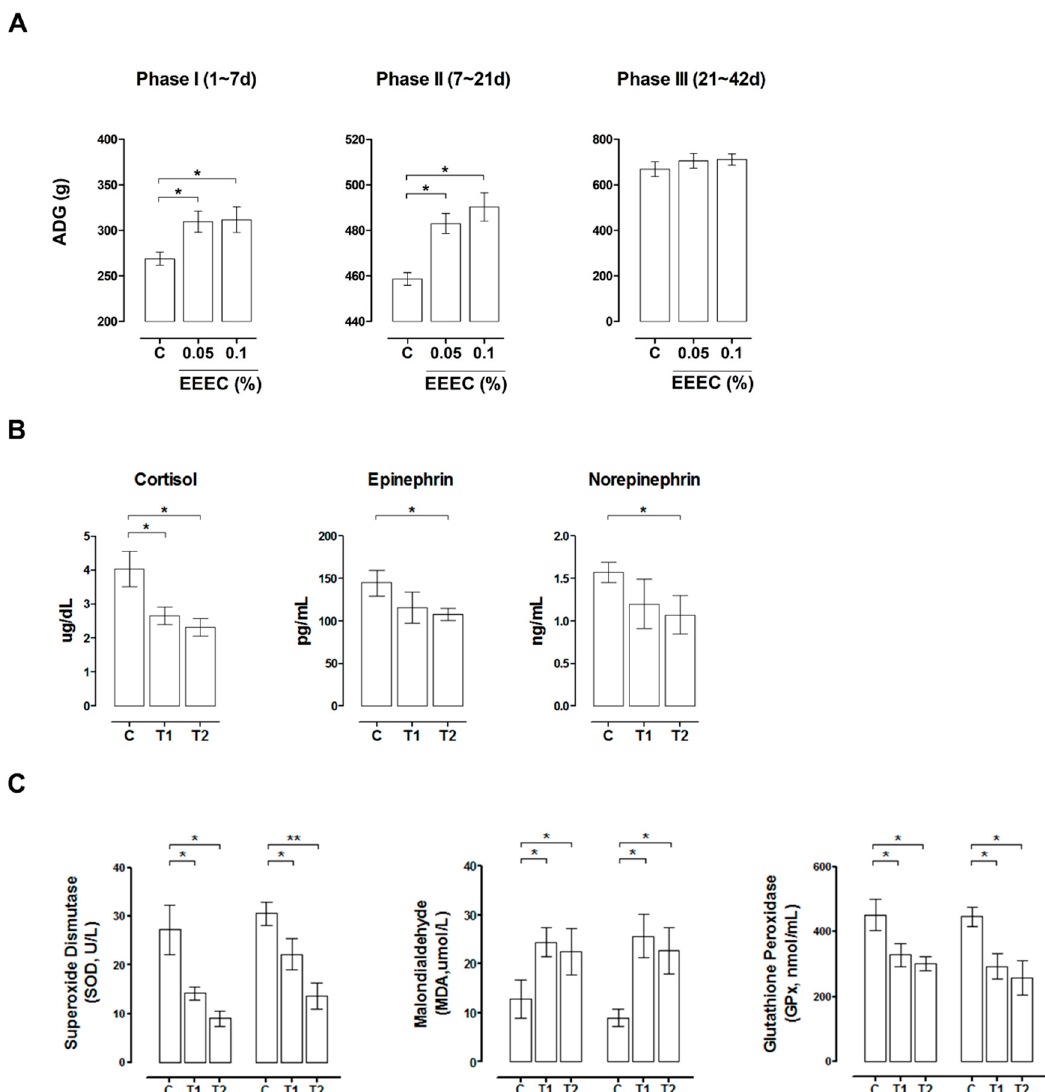
Figure 8. In vivo feeding trial during the suckling-to-weaning transition in pigs. The pigs were sorted into pens (n = 5 per pen, eight pens per treatment) and assigned to the following feeding groups: corn-soybean meal (C, control); control + 0.05% EEEC (T1); control + 0.1% EEEC (T2). ( A ) Dietary ethanol extract of dried E. cava (EEEC) supplementation improved average daily gain (ADG) in pigs during three developmental phases (days 1–7, 7–21, and 21–42). Serum levels of stress-related hormones, such as cortisol, epinephrine, and norepinephrine ( B ); and oxidative stress markers, such as superoxide dismutase (SOD), malondialdehyde (MDA), and glutathione peroxidase (GPx) ( C ), were determined through an enzyme-linked immunosorbent assay (n = 10). Error bars indicate the standard error of triplicate analyses. * p < 0.05 and ** p < 0.01